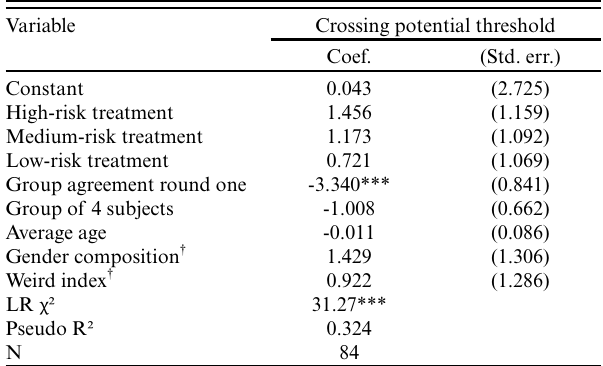
Table 4 . Logistic regression results on crossing the potential threshold.